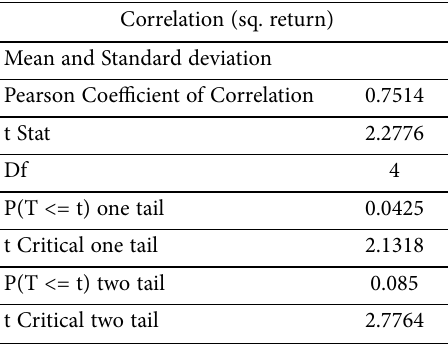
Table 3. Correlation (average return &